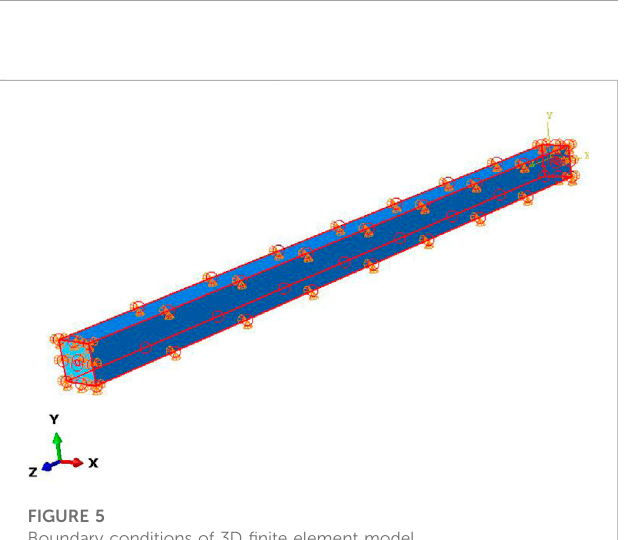
FIGURE 5 Boundary conditions of 3D fi nite element